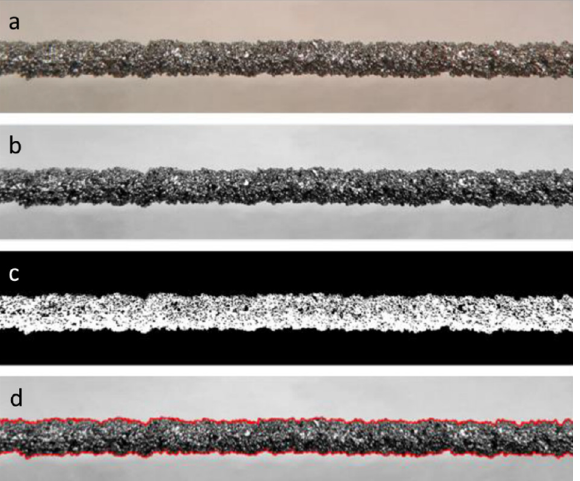
Figure 7. Image elaboration sequence: ( a ) cutting of unused areas; ( b ) conversion to grayscale; ( c ) binarization; ( d ) profile identification.